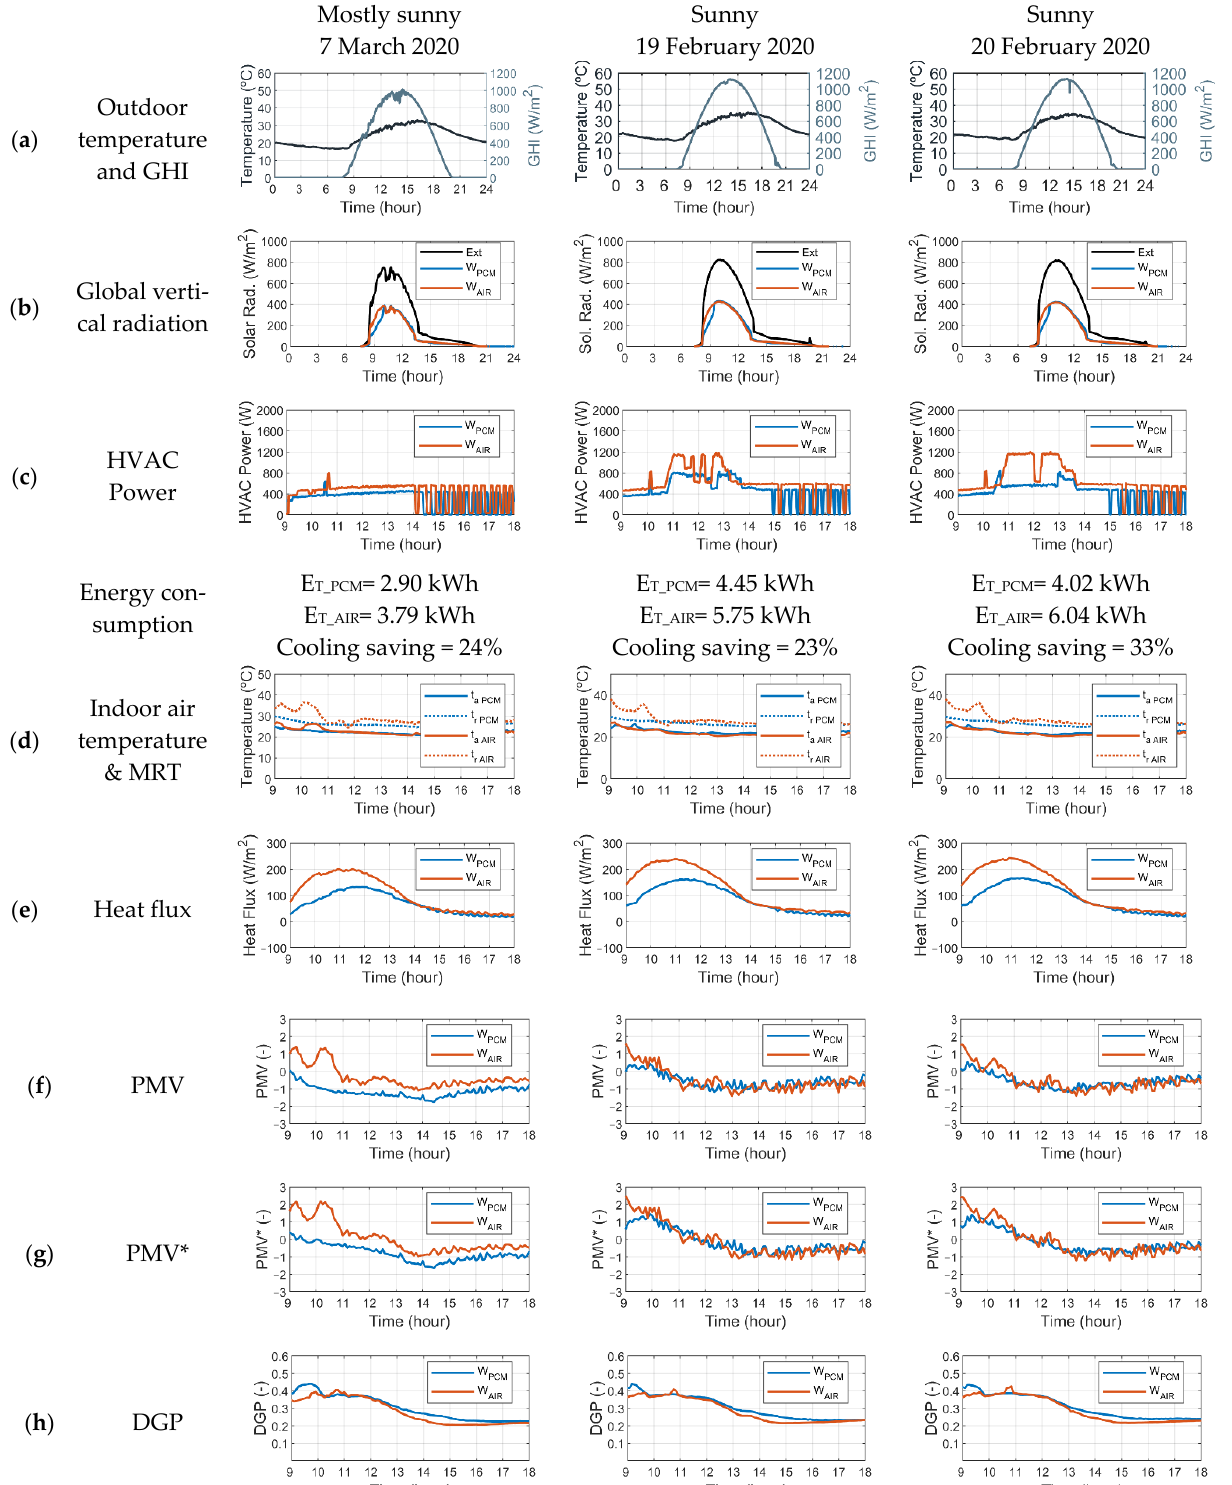
Figure 8. Seasonal results of DGP.